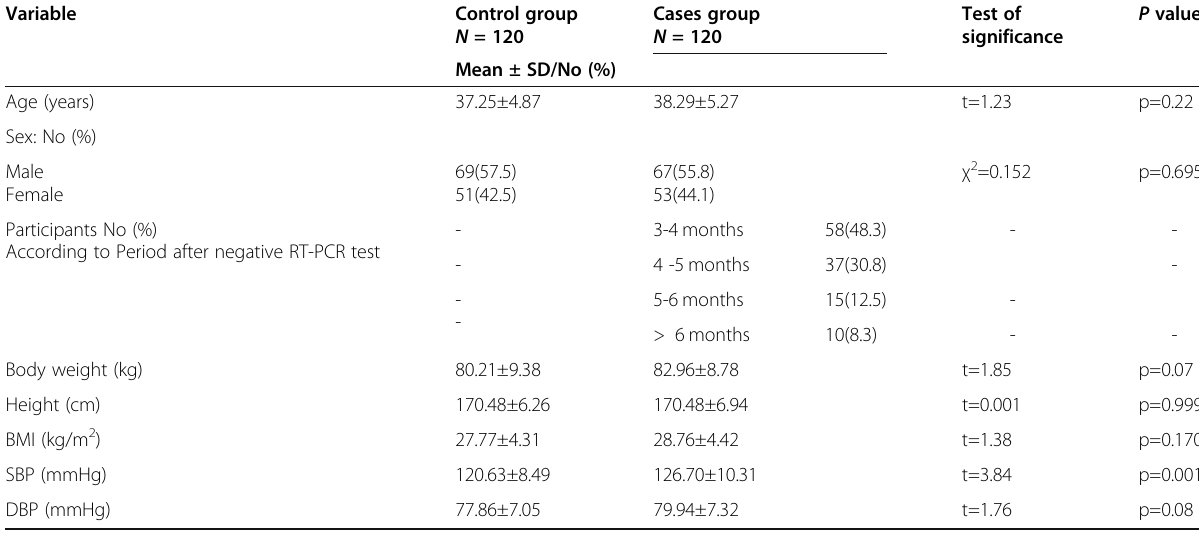
Table 1 The clinical characteristics of participants